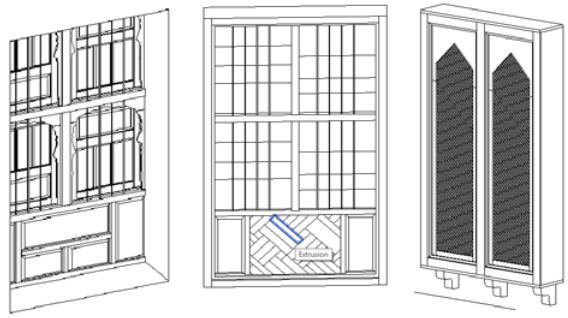
Figure 6. Generation of historical wooden windows elements